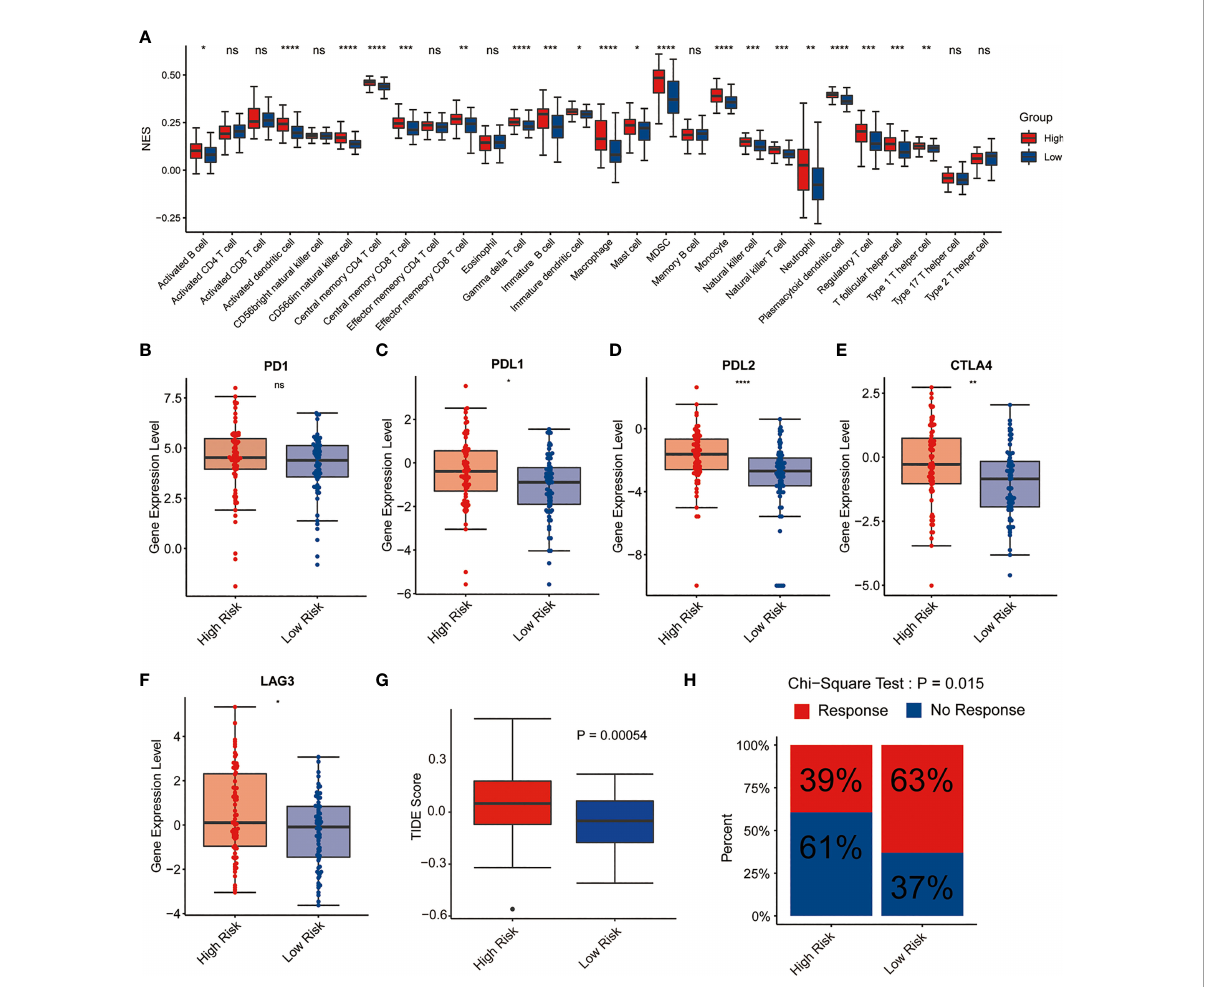
FIGURE 6 Immune cell in fi ltration and immunotherapy response of high-risk and low-risk groups with AML. (A) Correlation of risk score and immune cell in fi ltration by ssGSEA algorithm. (B – F) Expression of PD1, PDL1, PDL2, CTLA4, and LAG3 in the two risk groups. (G) TIDE score in the two risk groups. (H) Immunotherapy response rate in the two risk groups. *P<0.05, ** P<0.01, *** P<0.001, ****P<0.0001, ns, not signi fi